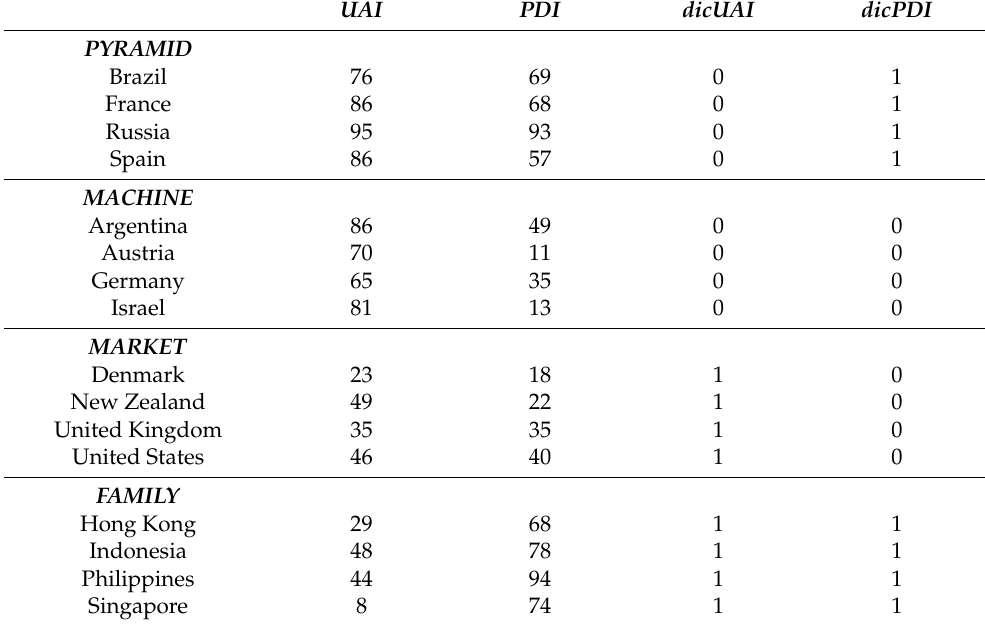
Table 2. Culture variable values for countries in the sample. UAI PDI dicUAI